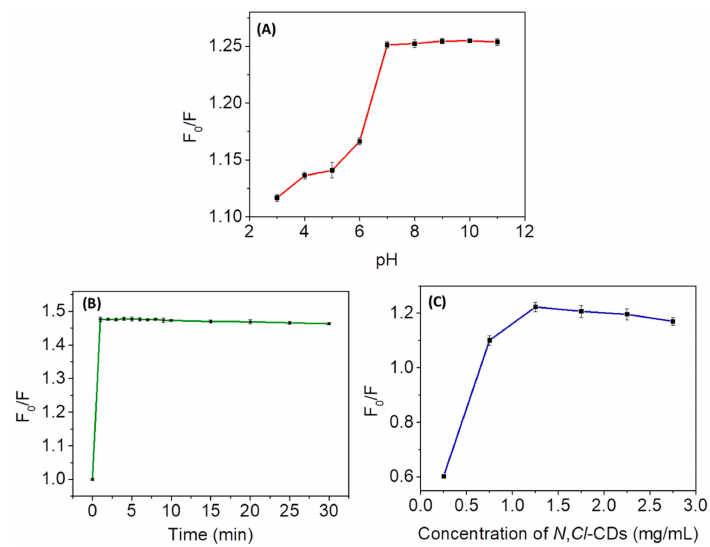
Figure 3. ( A ) Effect of pH on F 0 /F. 10 mM PBS solutions (pH 3-11) were used for the experiments. The concentrations of N , Cl -CDs and Cr(VI) used were 1.25 mg/mL and 6 µ M, respectively; ( B ) effect of reaction time on F 0 /F. The N , Cl -CDs and Cr(VI) were dissolved in ultrapure water, and their concentrations were 1.25 mg/mL and 6 µ M, respectively; ( C ) effect of the concentration of N , Cl -CDs on F 0 /F. The N , Cl -CDs and Cr(VI) were dissolved in ultrapure water, and the concentration of Cr(VI) used was 6 µ M.